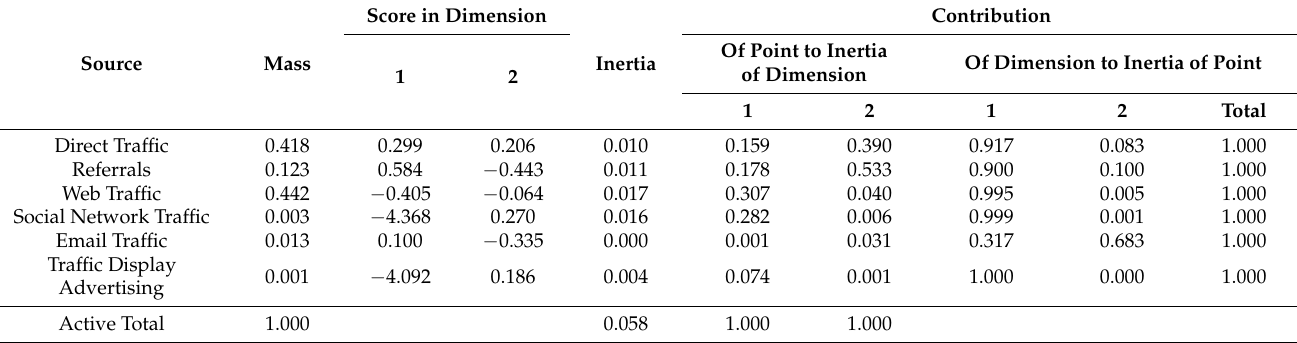
Table A3. Overview of correspondence score by column. Positioning and web traffic